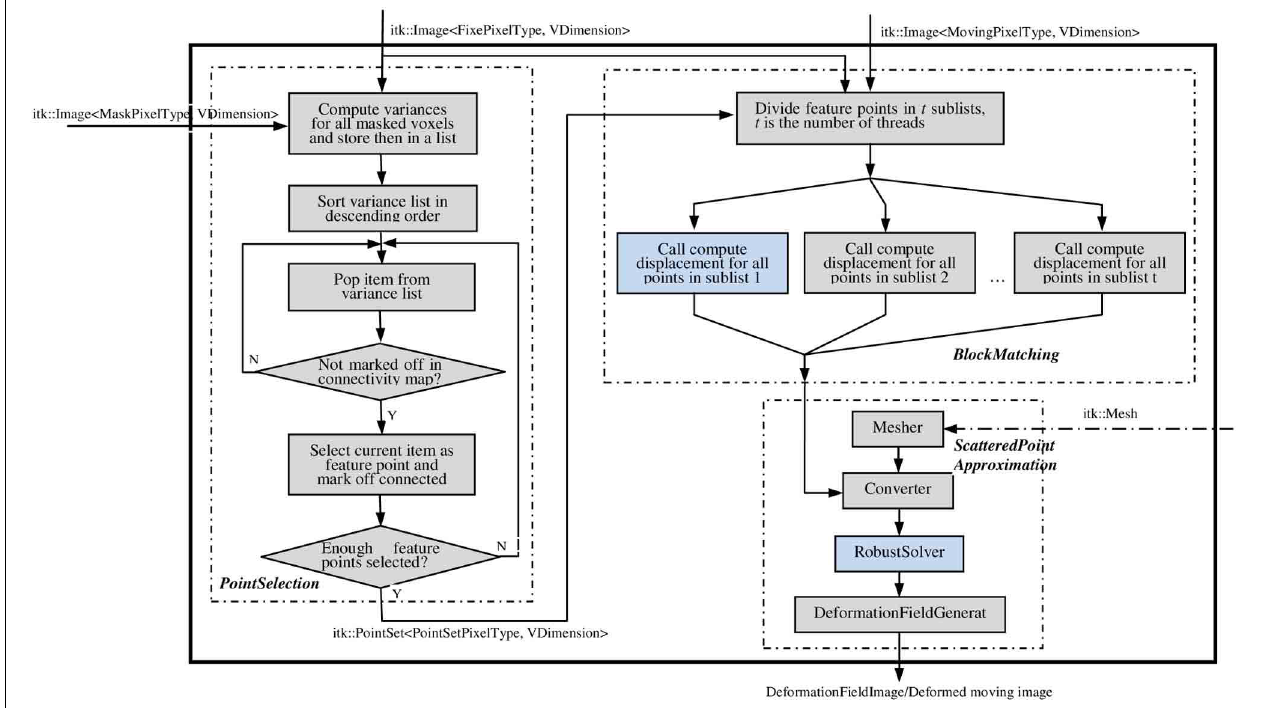
FIGURE 2 | The main filter PhysicsBasedNonRigidRegistration Method. This filter takes the fixed, moving, and mask images as the necessary inputs (solid line); takes the mesh as the optional